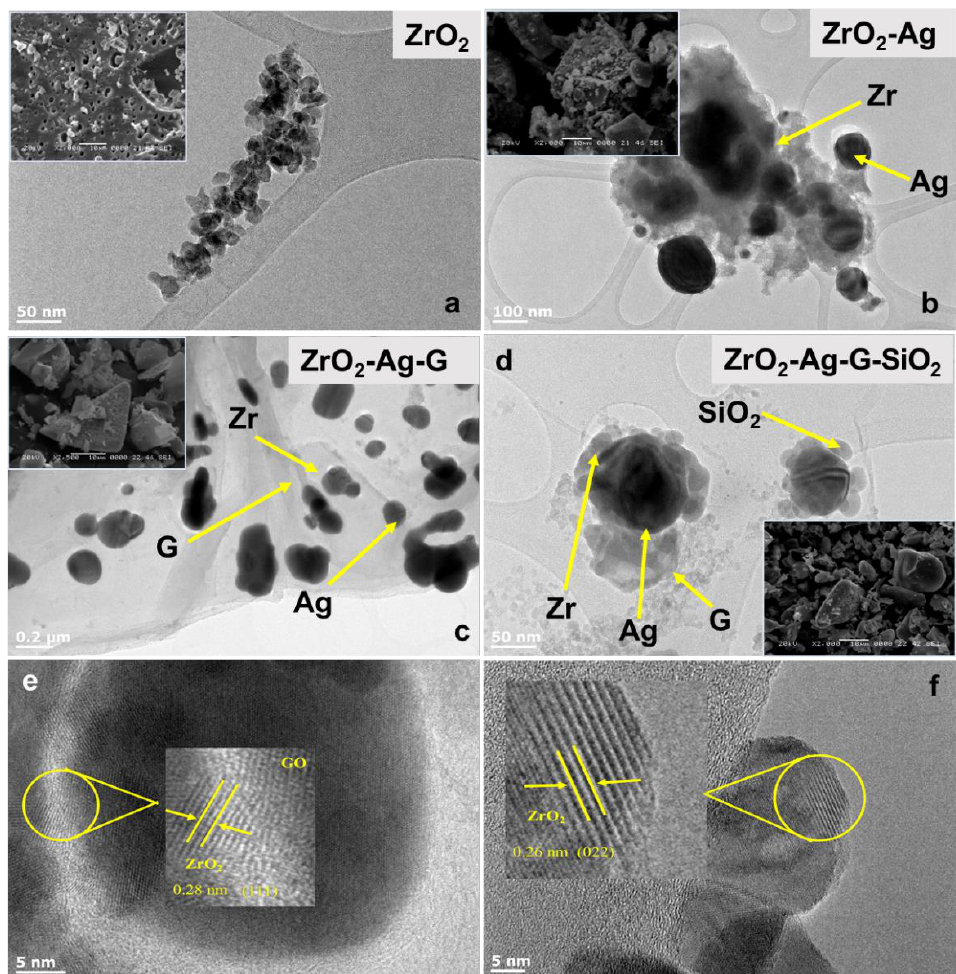
Figure 2. ( a ) ZrO 2 TEM Images and SEM Image (Inset), ( b ) ZrO 2 -Ag TEM Images and SEM Image (Inset), ( c ) ZrO 2 -Ag-G TEM Images and SEM Image (Inset), ( d ) ZrO 2 -Ag G-SiO 2 TEM Images and SEM Image (Inset), and ( e , f ) HRTEM Images of ZrO 2 Ag-G-SiO 2 .